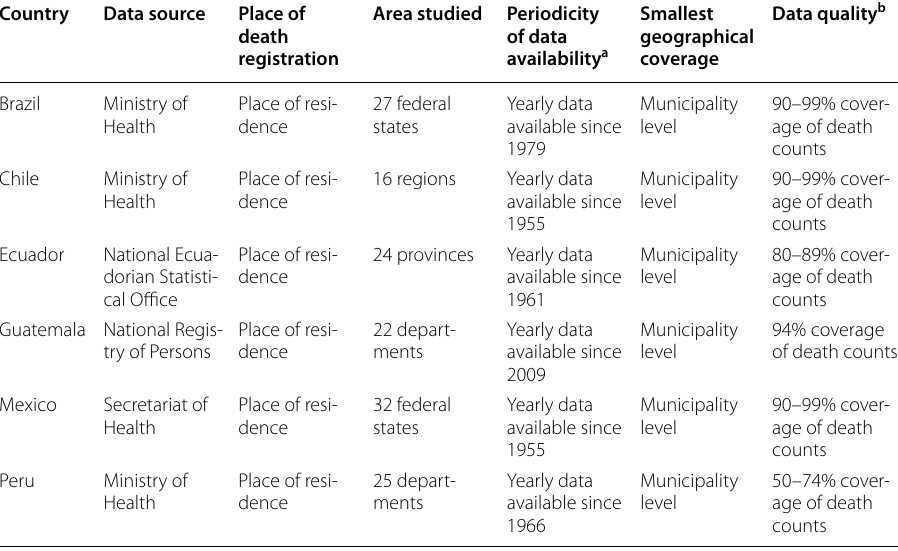
a The year that each country started to collect death information is from the World Health Organization b Based on the United Nations Demographic Yearbook Vital Statistics Questionnaire (United Nations Statistics Division) for the following years: 2017 (Brazil), 2020 (Chile), 2020 (Ecuador), 2007 (Guatemala), 2020 (Mexico), and 2015